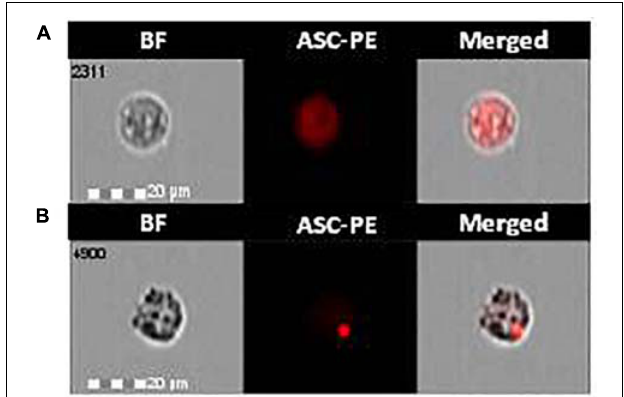
FIGURE 1 | ASC-speck formation in LPS-primed and monomeric or aggregated α -synuclein–stimulated cells of PD and HC subjects. Representative images of ASC-speck formation in LPS-primed and monomeric or aggregated α -synuclein–stimulated PBMCs of PD and HC subjects ( A , ASC-diffuse; B , ASC-speck). The first column shows cells in brightfield (BF), second column shows ASC-PE fluorescence, and third column shows florescence of ASC merged with brightfield (IDEA software). ASC-speck formation was analyzed using an internalization mask that recognizes two different patterns of ASC fluorescence inside cells: diffuse or spot (speck). Threshold mask was used to separate all ASC positive cells population in ASC-speck spot cells or ASC-diffuse cells by the different diameter of the spot area. In ASC-speck cell, the spot showed a small area and high max pixel; conversely in ASC-diffuse cell, the fluorescence showed a large area and low max